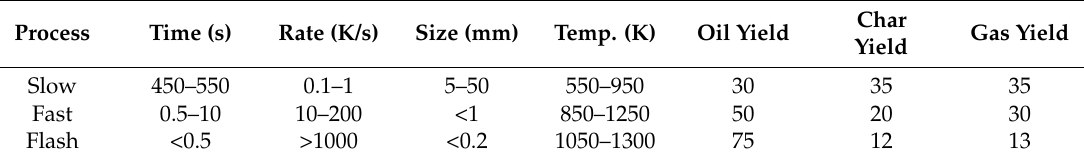
Table 3. Operating parameters of different pyrolysis